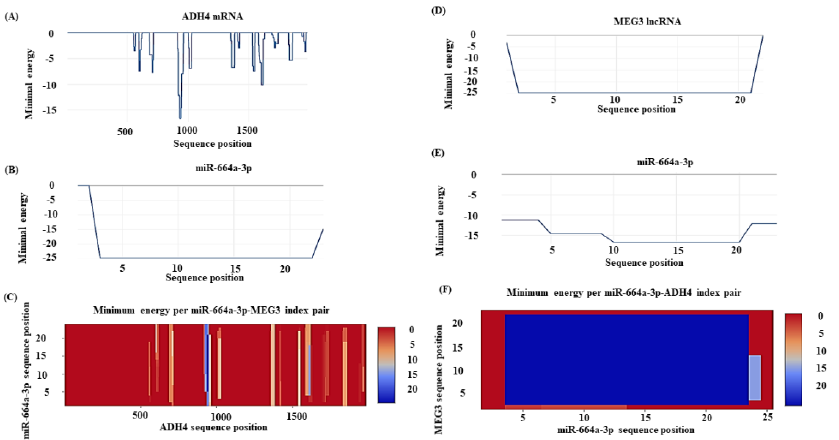
Figure 5. Prediction of accessible regions in RNA heteroduplexes. ( A ) Graph showing minimum free energy prediction for stable ADH4 mRNA. ( B ) Graph showing minimum free energy prediction for stable miR-664a-3p. ( C ) Minimum free energy prediction for the miRNA–mRNA hybrid. ( D ) Graph showing minimum free energy prediction for stable lncRNA MEG3 structure. ( E ) Graph showing minimum free energy graph for the stable miR-664a-3p structure. ( F ) Minimum free energy prediction for the lncRNA–miRNA hybrid.